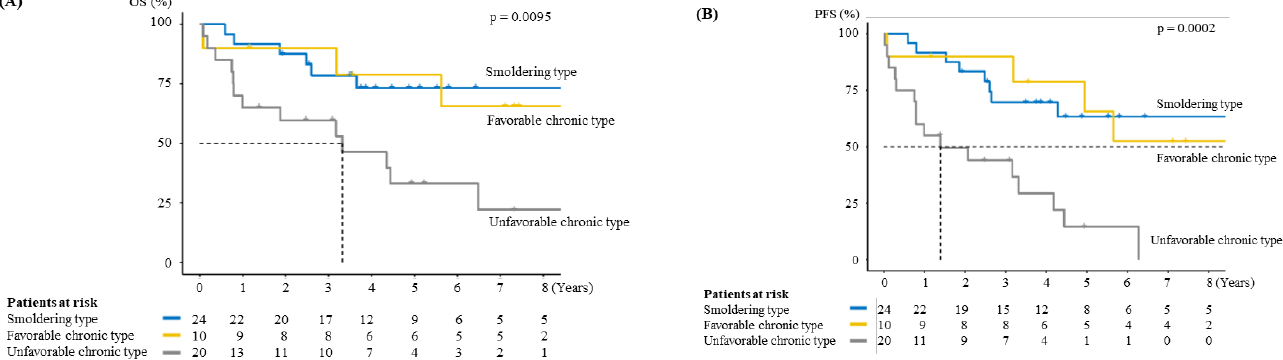
Figure 1. ( A ) Overall survival (OS) and median survival time (MST) by adult T-cell leukemia/lym- phoma (ATL) subtype (smoldering, favorable chronic, and unfavorable chronic). ( B ) Progression-free survival (PFS) by ATL subtype.